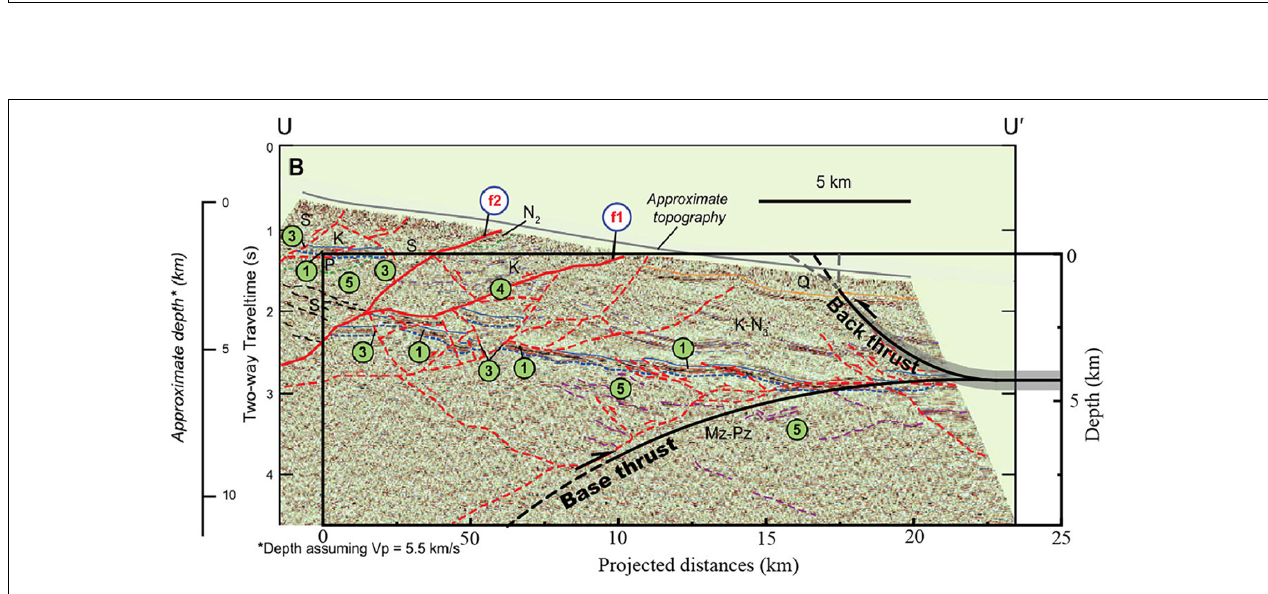
FIGURE 7 | Comparison between the fault geometries estimated by terrace deformation, and the interpretation form the seismic reflection profile of Zuza et al. (2016).